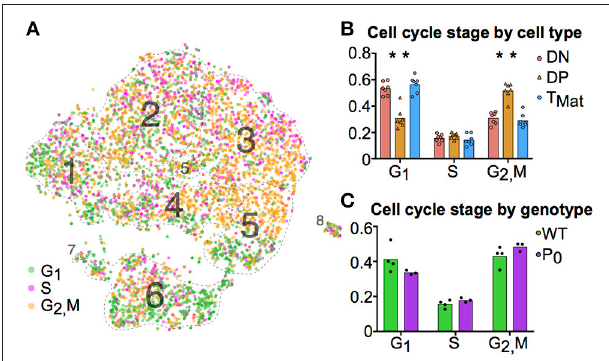
FIGURE 4 | T-cell maturation and cell cycle stage are linked. (A) Individual cells were scored for their cell cycle genes (G 1 , S and G 2 /M, as described in Methods). (B) The proportions of these cells within each cell population were compared using student t -tests (DN, Cluster 1; DP, Clusters 2-5; T Mat , Cluster 6). (C) The proportion of WT and P 0 cells in each phase were compared. (* P < 0.05; n =